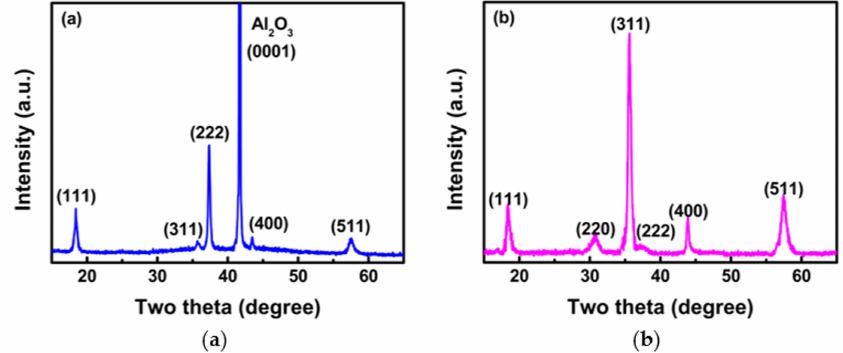
Figure 2. XRD patterns of ZnGa 2 O 4 films grown on ( a ) sapphire and ( b ) Si(100)